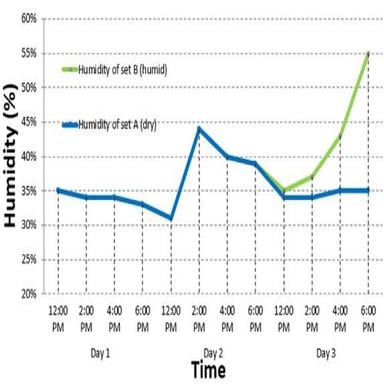
Humidity conditions for the flexural test.